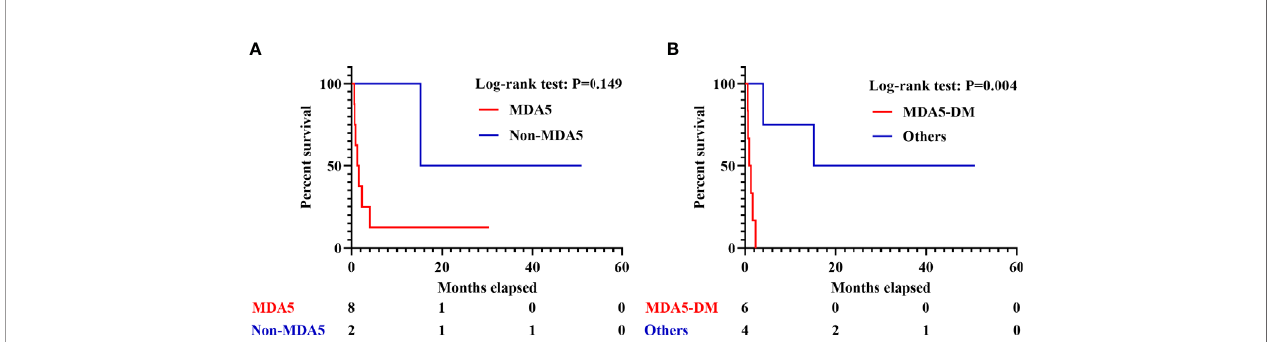
FIGURE 5 | Survival analyses in IIM patients with sHLH. (A) Survival of sHLH patients with or without positivity of anti-MDA5 antibody. (B) Survival of anti-MDA5- positive DM patients and the other patients. IIM, Idiopathic in fl ammatory myopathy; sHLH, Secondary hemophagocytic lymphohistiocytosis; DM,